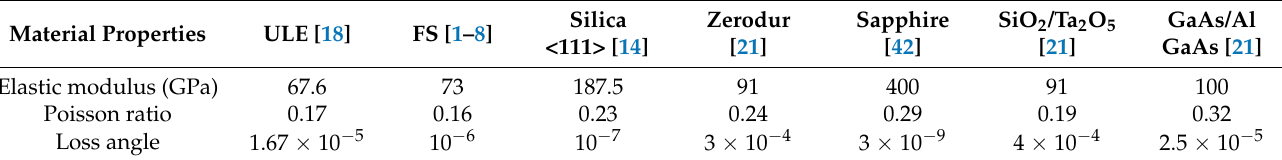
Table 2. Material